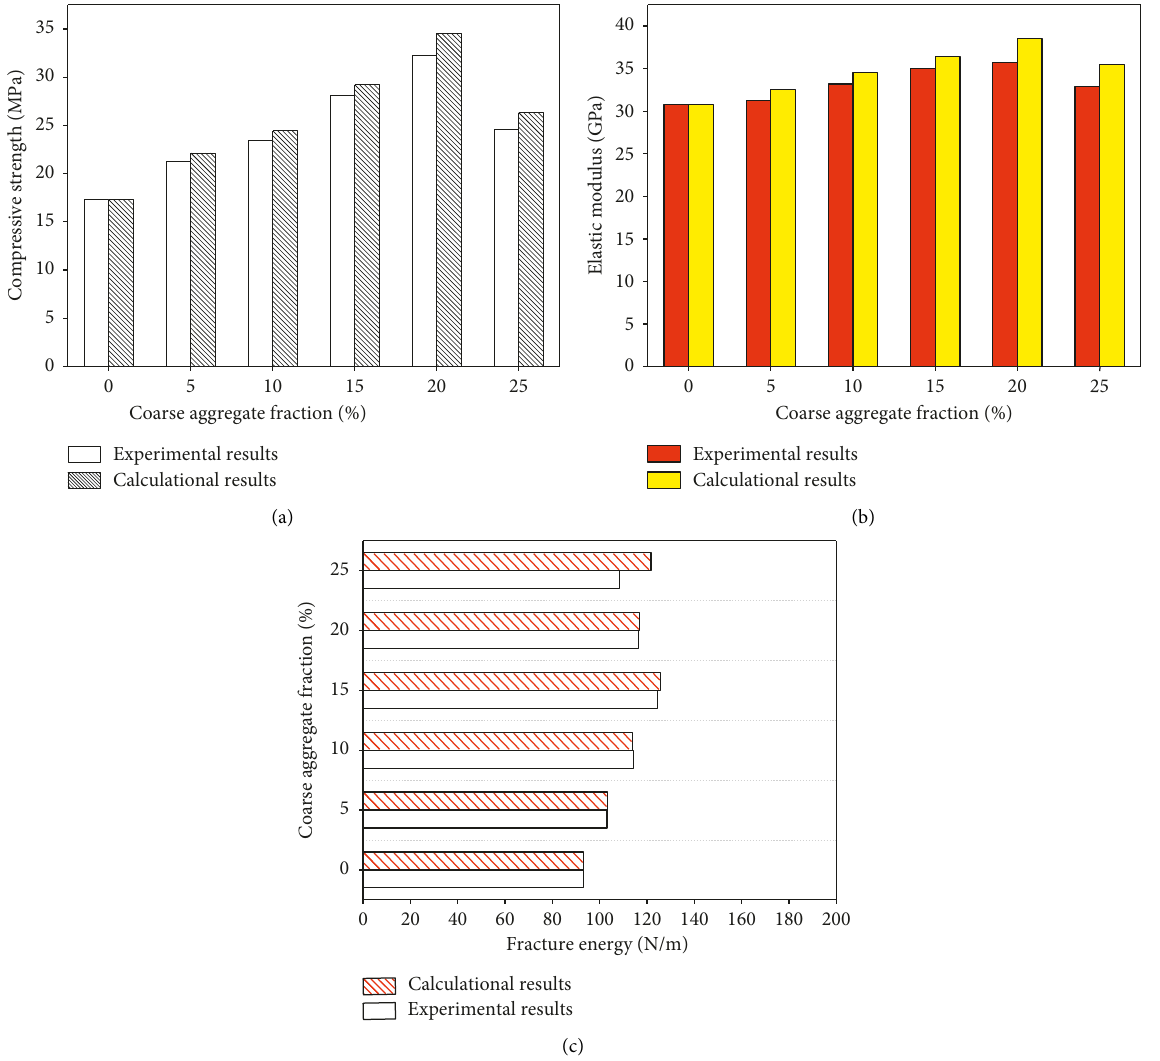
Figure 10: Comparison results of experiment and simulation calculation of the coarse aggregate interlocking concrete. (a) Compressive strength. (b) Elastic modulus. (c) Fracture